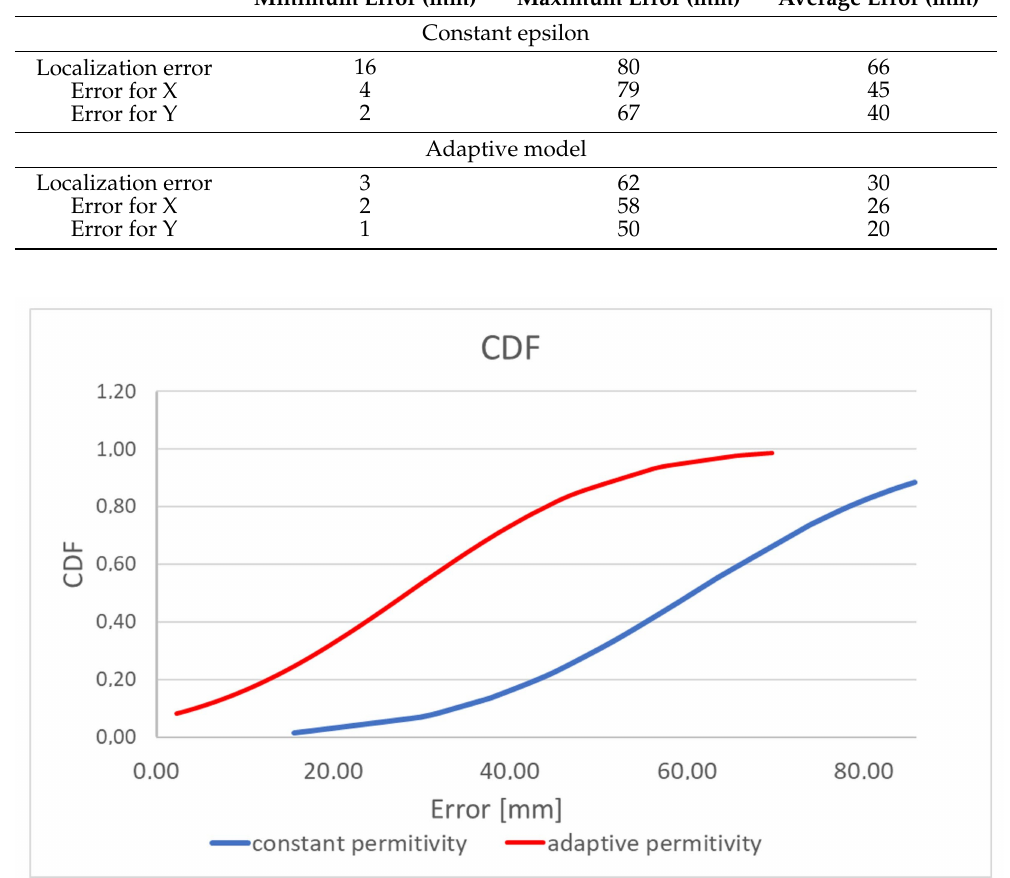
Figure 16. Cumulative distribution function (CDF) of localization error for measurements with physical